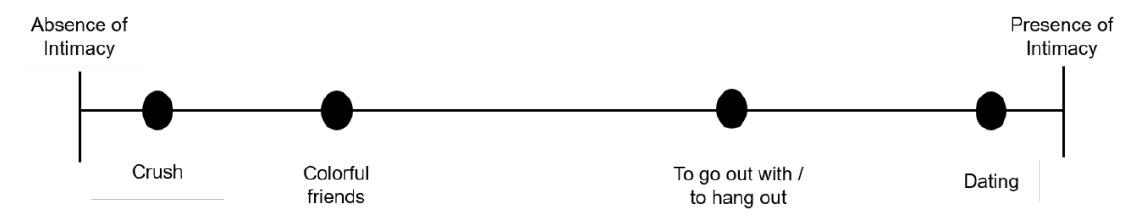
Figure 2. Spectrum of the representation of intimacy in love relationships between adolescents.